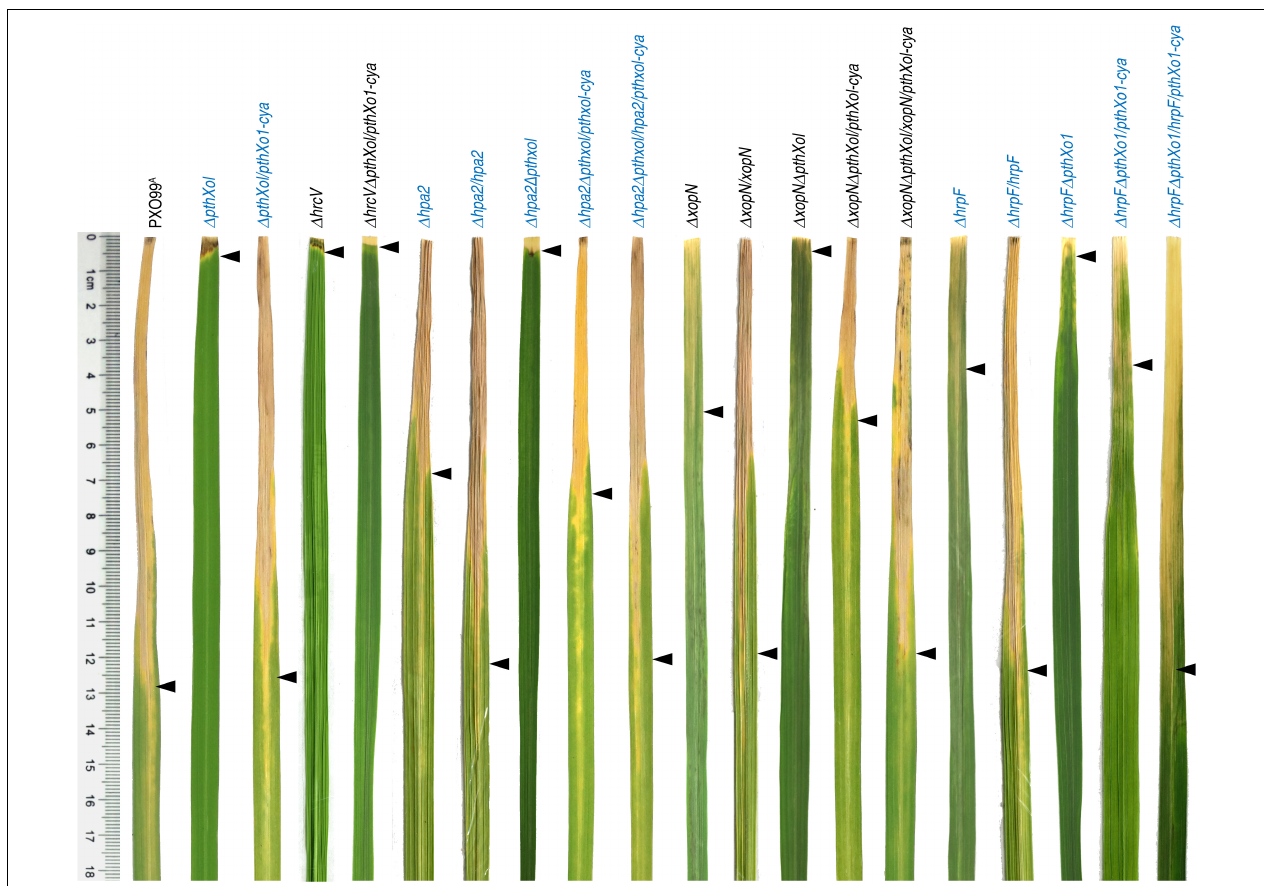
FIGURE 2 | Bacterial blight symptoms on leaves of rice plants inoculated separately with PXO99 A and mutants related to hpa1 , hpa2 , hrpF , and hrcV . Inoculation was performed on 30-day-old Nipponbare rice seedlings by using the leaf-clipping method. 12 h later, inoculated leaves were excised, spread on papers by the aid of sellotapes, and photographed. Leaf images were aligned, brightness/contrast was adjusted by a uniform extent, and background shadings were eliminated by using the magic wand and cut-off tools in Photoshop. Each leaf photo represents 30 leaves of 15 plants assessed in 3 independent